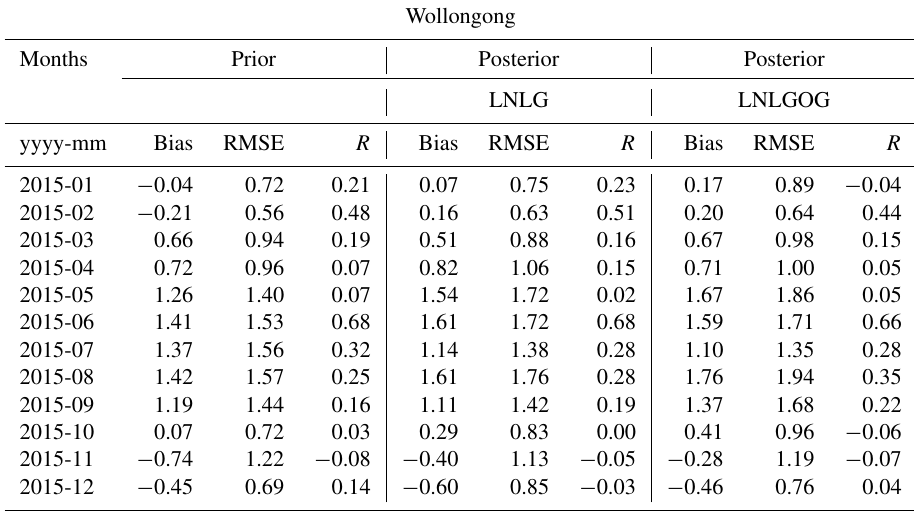
Table G2. Analysis of the residual between CMAQ prior and posterior simulations and the TCCON Wollongong site for 2015: averaged bias, RMSE and Pearson’s coefficient ( R ).